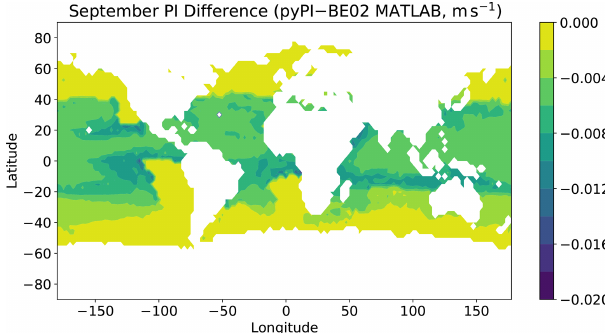
Figure 4. September 2004 mean potential intensity differences (ms − 1 ) between those calculated with pyPI minus those calculated with the BE02 MATLAB